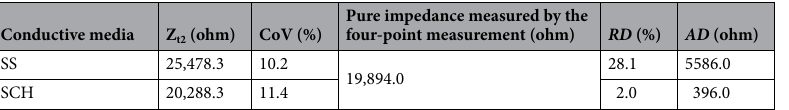
Table 6. Relative deviation of sample impedance evaluated by two-point measurement with SS and SCH. RD means the relative deviation of contact impedance evaluated by the two-point measurement to pure sample impedance. AD means absolute deviation of contact impedance evaluated by the two-point measurement to pure sample impedance. CoV means the variation coefficient of the test results of three samples.